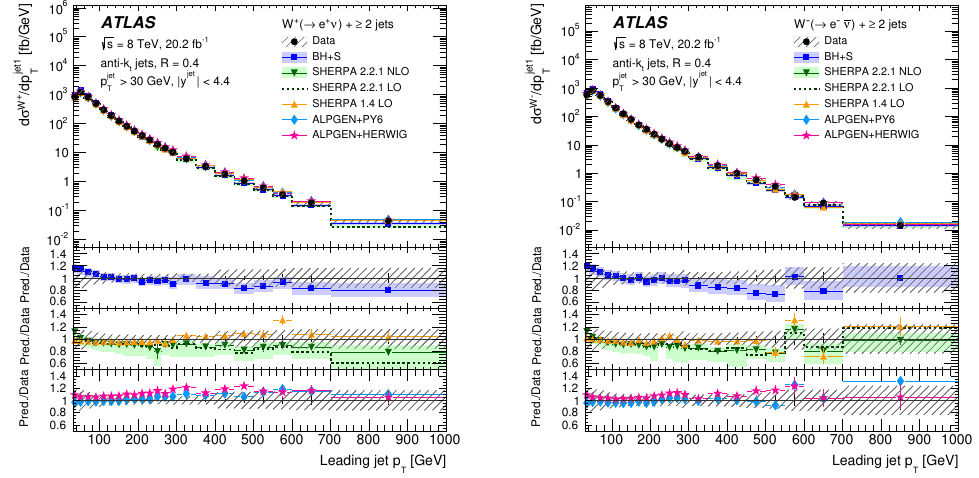
Figure 27 . Di(cid:11)erential cross sections for the production of W + (left) and W (cid:0) (right) as a function of the leading jet p T for events with N jets (cid:21) 2. For the data, the statistical uncertainties are indicated as vertical bars, and the combined statistical and systematic uncertainties are shown by the hatched bands. The uppermost panel in each plot shows the di(cid:11)erential cross sections, while the lower panels show the ratios of the predictions to the data. The theoretical uncertainties on the predictions are described in the text. The arrows on the lower panels indicate points that are outside the displayed